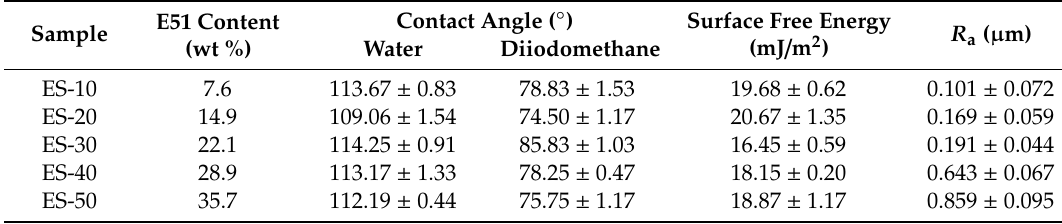
Table 2. Surface properties of the epoxy modified silicone coating.